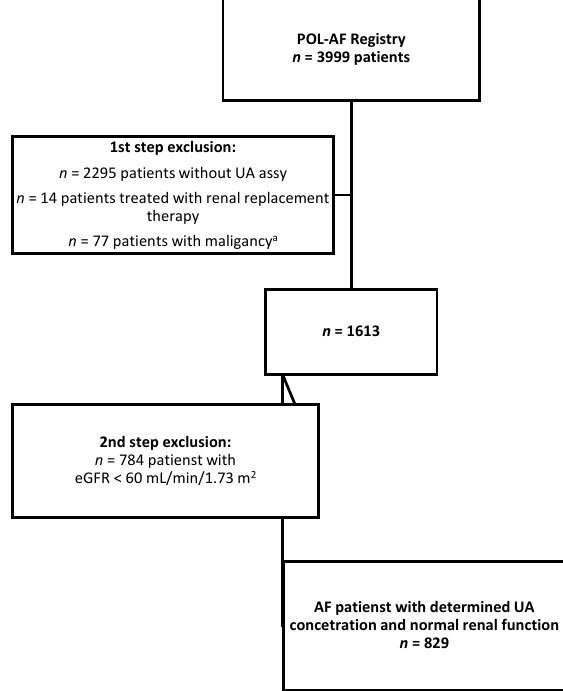
Figure 1. Flowchart shows the study selection process. Abbreviations: UA, uric acid; eGFR, estimated glomerular filtration rate. a A malignancy was defined as active cancer or a cancer treatment completed less than one year before the date of